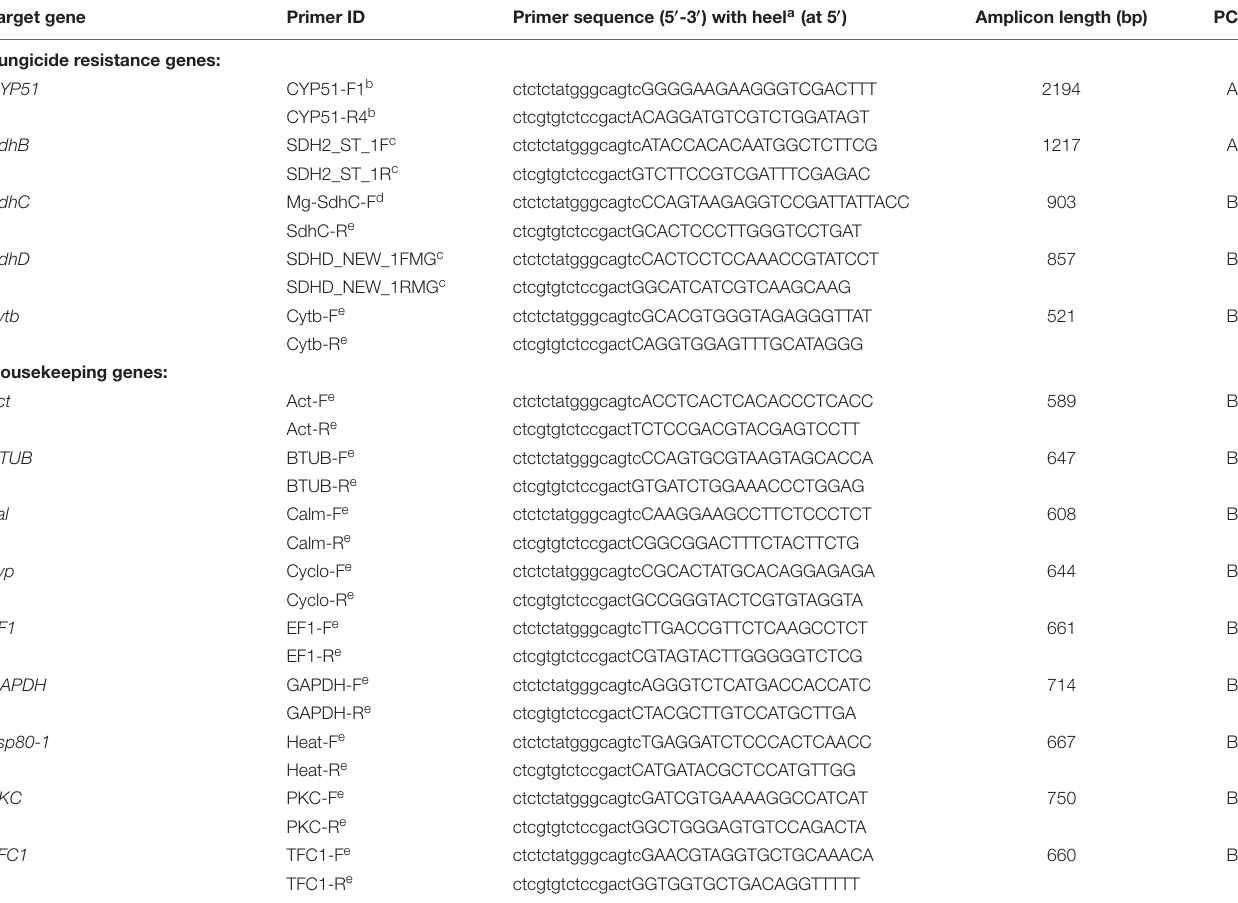
TABLE 2 | Primers used in two multiplex PCRs to amplify fungicide target and housekeeping genes in Zymoseptoria tritici . Target